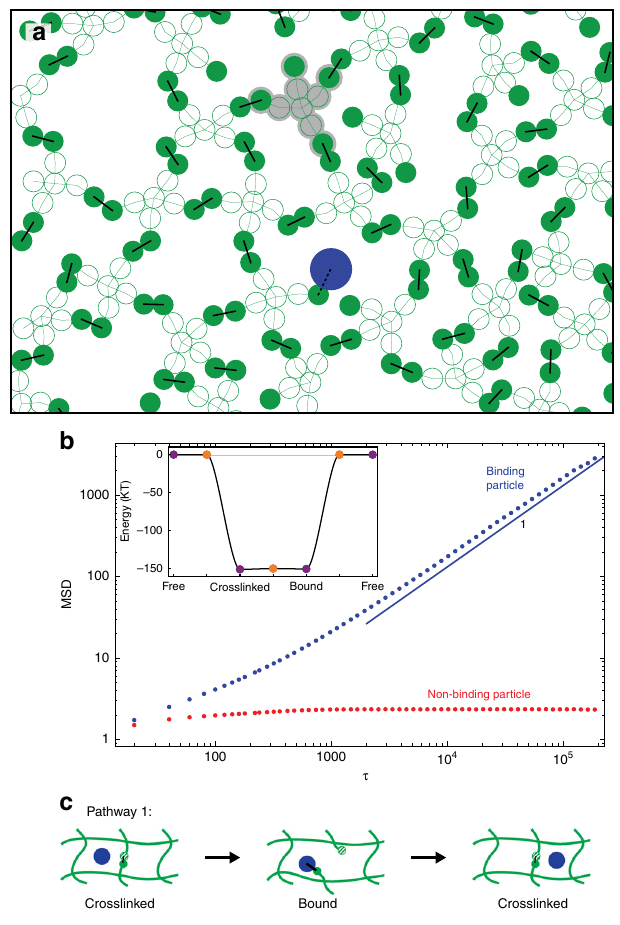
Fig. 3 Perfect fi ltering in a gel with high binding af fi nities. a A diffusing particle (blue) and the surrounding gel (green). The gel is composed of star-shaped polymers that have a central particle connecting 4 polymer strands each of length 2 (the light green lines show permanent bonds within the polymers). One star-shaped polymer is shaded gray for clarity. The strand ends (solid circles) can be in one of three states: (1) free, (2) crosslinked with another strand end (solid black lines), or (3) bound to a particle (dashed black line). b Mean squared displacement of a binding particle (blue) and a non-binding particle (red) obtained from Brownian Dynamics simulations. Since the crosslinks are permanently bound, the non-binding particle is caged inde fi nitely and does not diffuse. However, the binding particle is able to escape its cage, and as a result has a non-zero diffusion constant. See Supplementary Movie 1. Inset: state and transition state energies used in these simulations. For these simulations, E f = T fc = T = 0, while E = − 150.5 k T and T = E = − 150 k T . c A sketch of how a bf c B cb b B binding particle can diffuse through a gel by breaking crosslinks. Note that the binding site on the gel (solid green disk) is never in the free state, but instead transitions directly between the crosslinked and bound states. In this way, the particle can escape the cage while the total energy remains (roughly) constant since the total number of bonds in the system